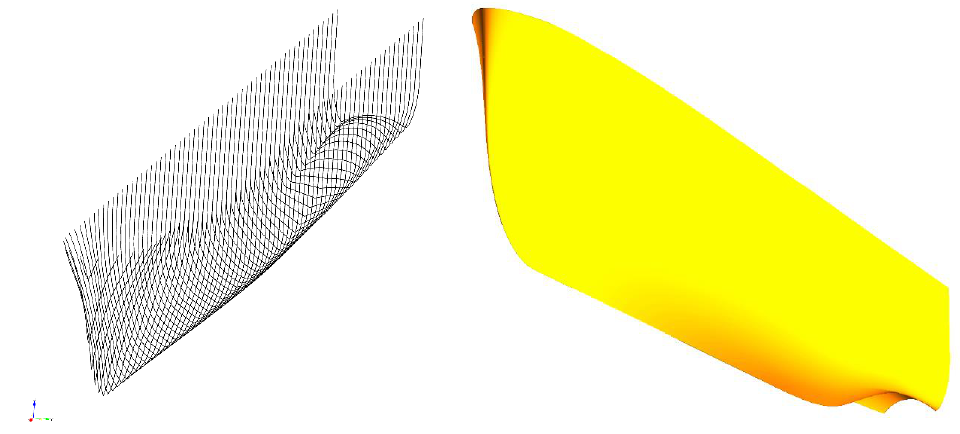
Figure 14. 3D wireframe and faired surface view of the numerically optimized Stavanger hull form. J. Mar. Sci. Eng. 2020 , 8 , x FOR PEER REVIEW